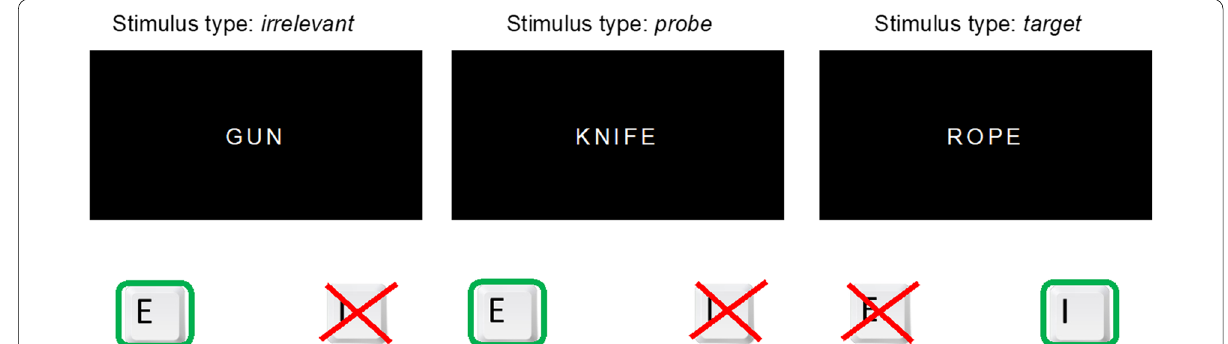
Fig. 1 Item classification in the RT-CIT. Note Example items (as they would be displayed on a computer screen) and corresponding classification via keypresses for the Response-Time Concealed Information Test (RT-CIT), illustrated with a hypothetical murder case. The true murder weapon, in this case knife , serves as the probe, while four similar items, that are indistinguishable from the probe for naïve examinees, serve as irrelevants (e.g., here, one of these four is gun ) and one additional irrelevant item serves as the target (here: rope ). Irrelevants and probe have to be classified by